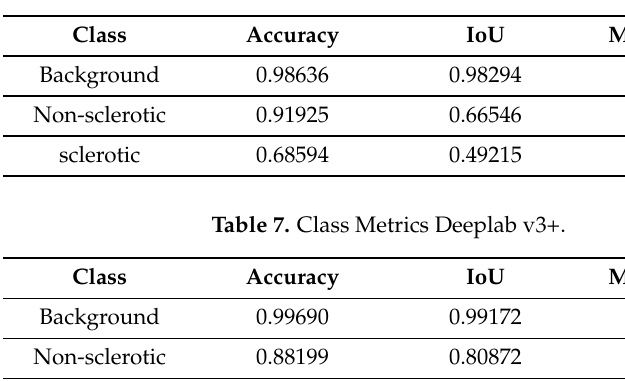
Table 6. Class Metrics SegNet.